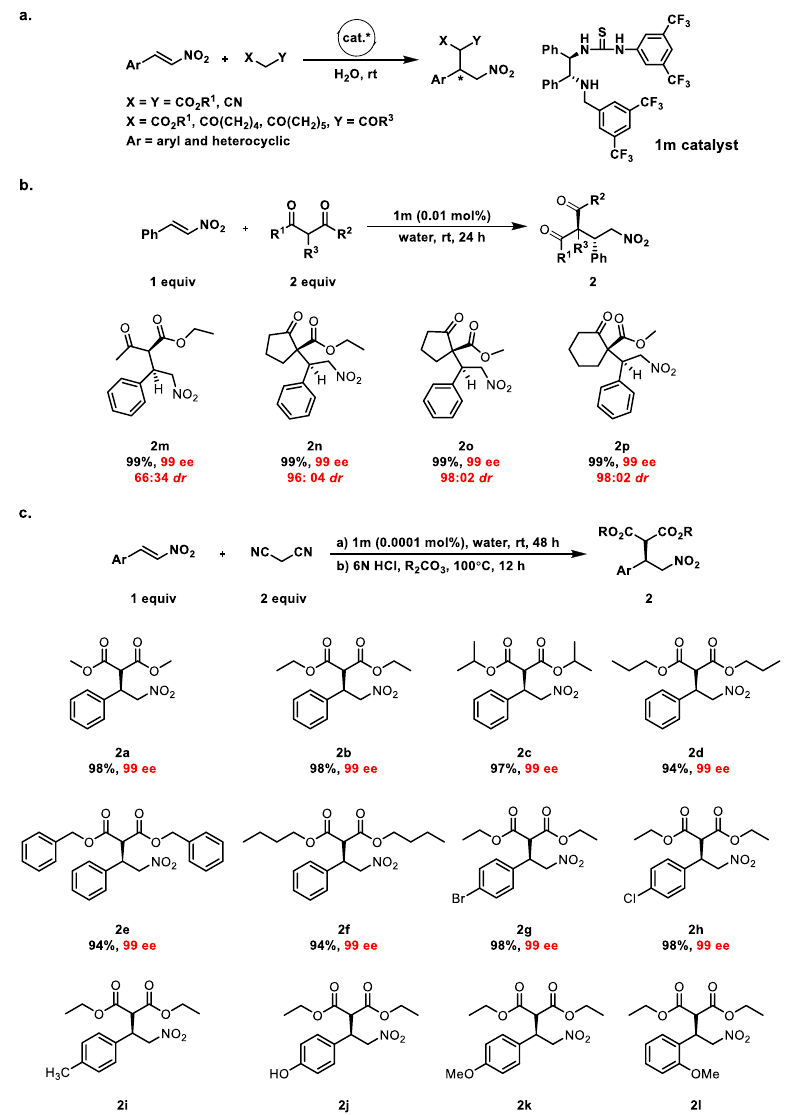
Figure 2. R- form products of the Michael reaction using β -nitrostyrenes. ( a ) Synthesis concept and reaction scope of the substrate for Michael reaction. ( b ) Scope of the Michael reaction using a range of β -keto esters. The reaction was conducted by using nitrostyrene (14 mmol), β −keto ester (28 mmol), water (20 mL), and catalyst 1m at room temperature. ( c ) Scope of the Michael reaction using a range of malononitriles. The reaction was conducted by using nitrostyrene (27 mmol), malononitriles (54 mmol), water (50 mL), and catalyst 1m at room temperature.